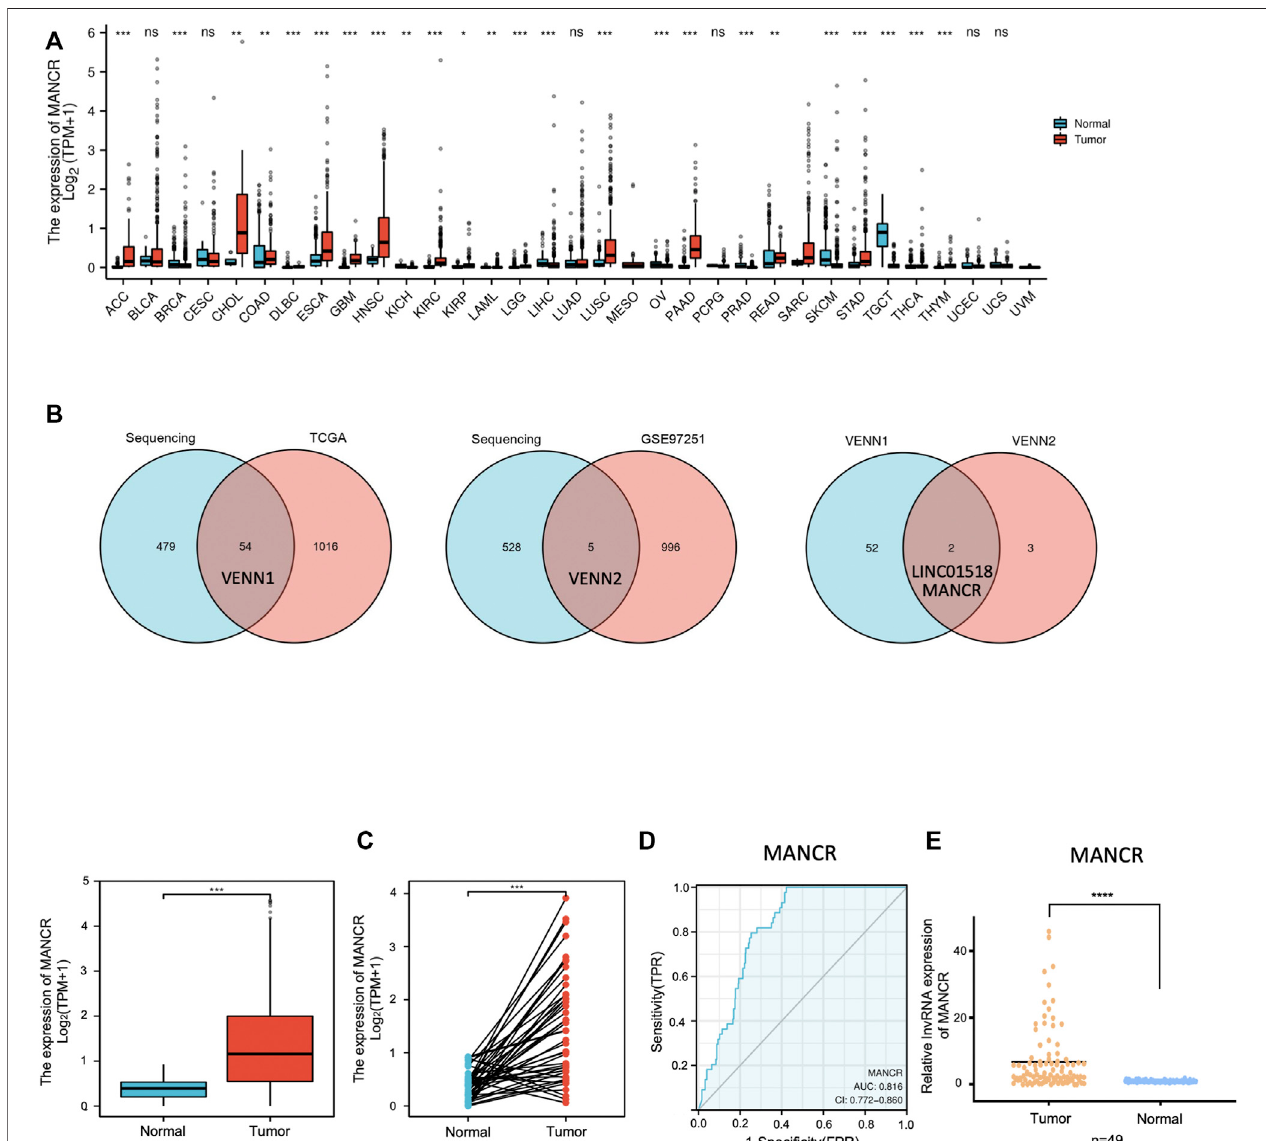
FIGURE1| MANCR expressionlevelinpan-cancersincluding HNSCC. (A) Differentexpression levels ofMANCRinmostcancertypes fromTGCA andGTEx data (* p < 0.05,** p < 0.01,*** p < 0.001,and**** p < 0.0001). (B) VennanalysisofpreviouslncRNAexpressionpro fi les,TCGA,andGEOdatabases. (C) MANCRexpressionof HNSCC tumor samples and adjacent normal samples from TCGA data (*** p < 0.001). (D) ROC curve for MANCR expression in TCGA HNSCC. (E) RT-qPCR result of MANCR expression in 49 HNSCC tumor tissues and adjacent normal tissues. Data were shown as mean ± SD (* p < 0.05, ** p < 0.01, *** p < 0.001, and **** p <